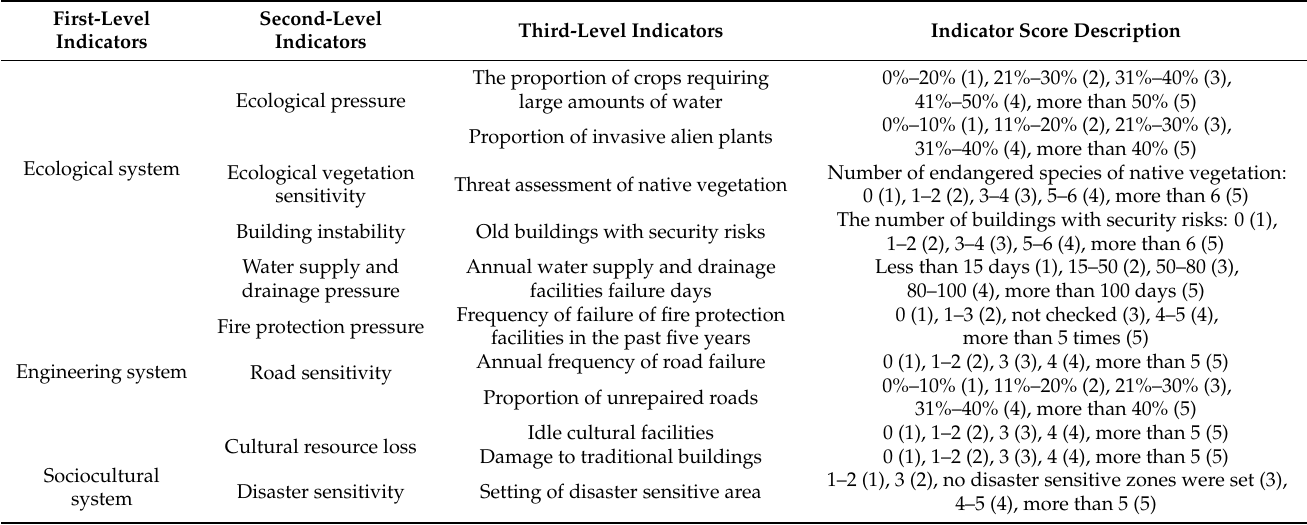
Table 2. Assessment indicators of rural landscape vulnerability in